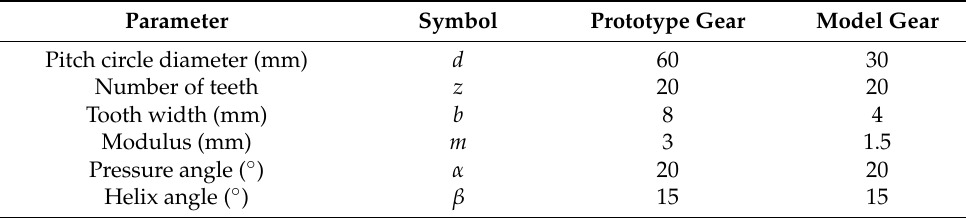
Figure 2. Force analysis diagram at different positions of the gear ( a ) local stress diagram, ( b ) stress distribution on the force surface of the large gear, ( c ) stress distribution on the back of the large gear, ( d ) root stress on the gear surface. Table 7. Prototype and model gear